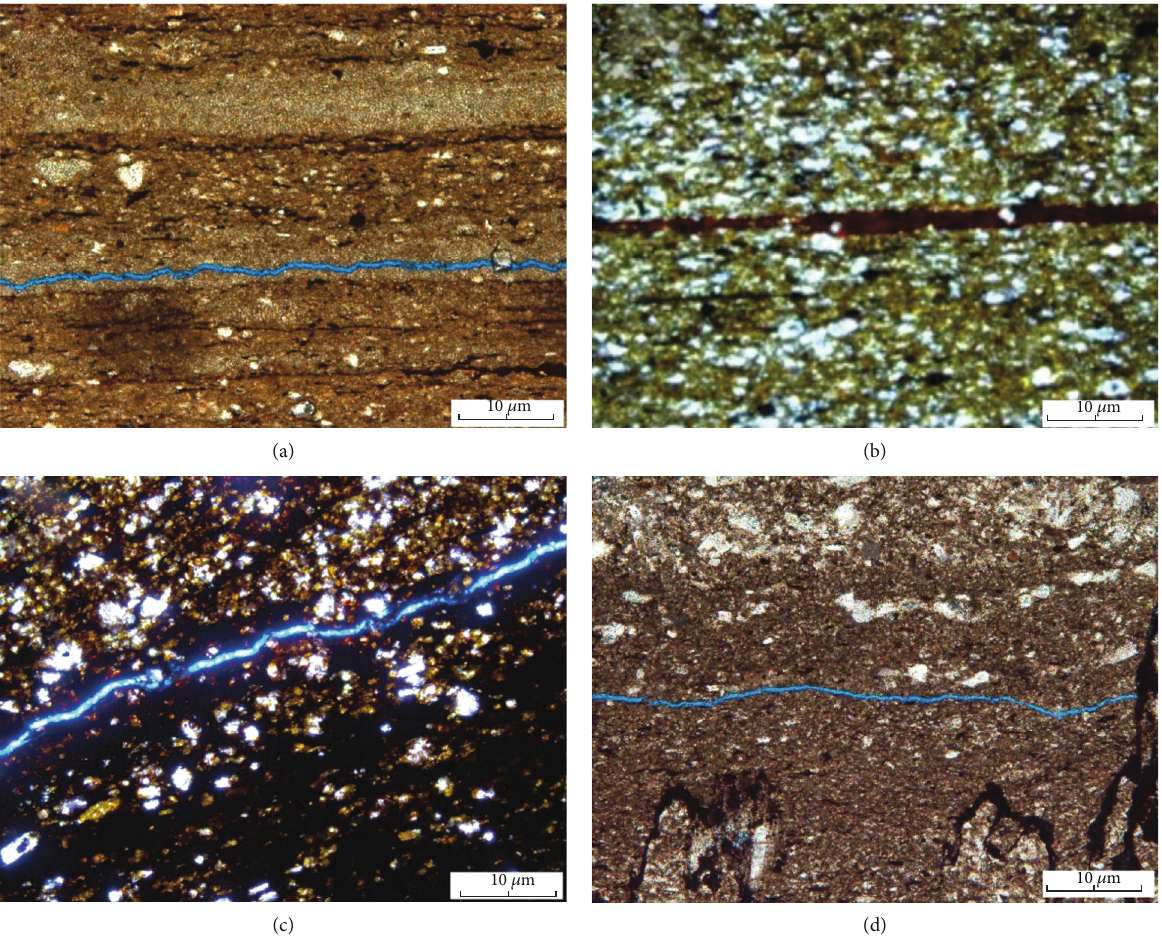
Figure 4: Photographs of bedding fractures in casting thin sections of rocks from Lucaogou formation in Jimsar sag. (a) Ji31, argillaceous siltstone, 2730.2m; (b) Ji37, mudstone, 2853.9m; (c) Ji251, dolomitic siltstone, 3769.3m; (d) Ji251, gray sandstone,